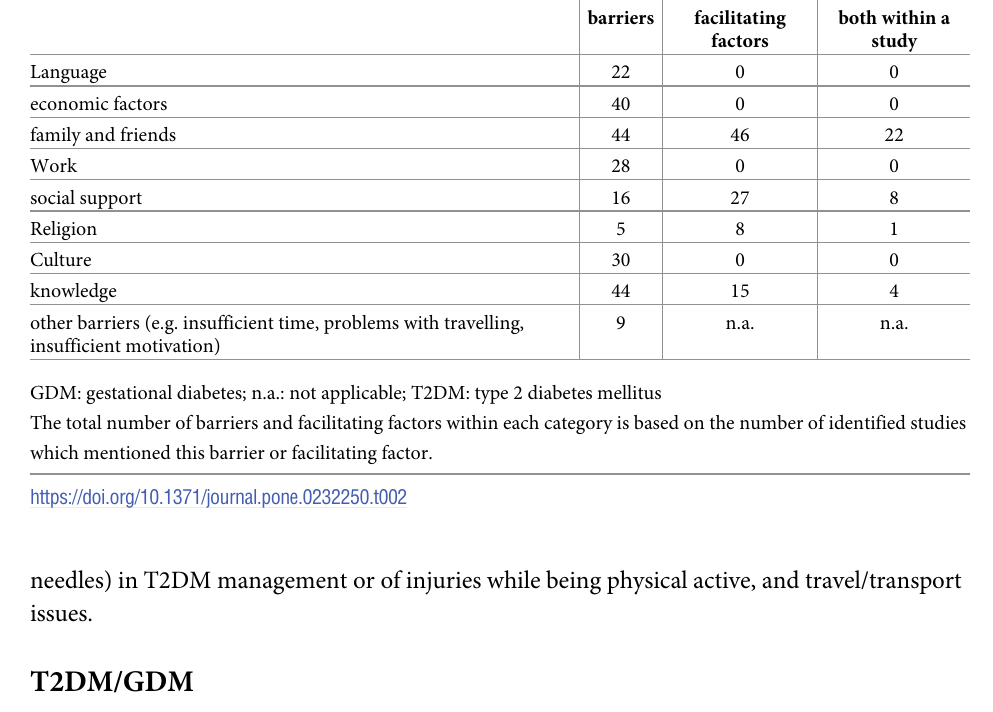
Table 2. Barriers and facilitating factor categories for implementing a preventive intervention for people with or at risk of